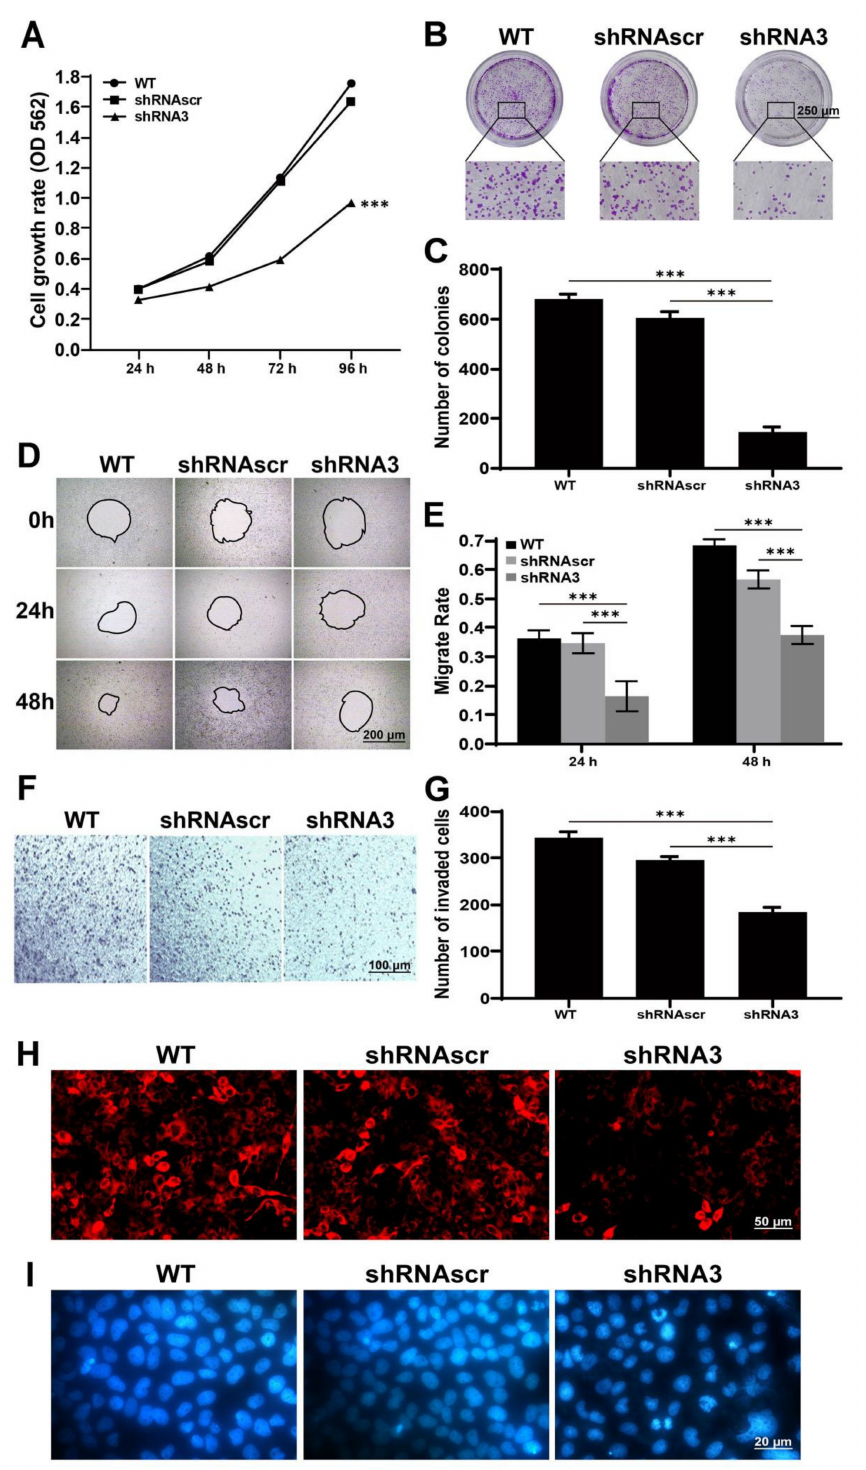
Figure 3. Knockdown of LEF1 inhibited cell proliferation and motility and induced apopto- sis in caco2 cells. ( A ): Cell viability determined by an MTT assay at 24, 48, 72, and 96 h af- ter transfection. ( B , C ): The growth of caco2 cells analyzed by a colony formation assay post- transfection (scale bar = 250 µ m). ( D , E ): Wound healing assay at 0, 24, and 48 h after scratching (scale bar = 200 µ m). ( F , G ): Transwell assay at 60 h after transfection (scale bar = 100 µ m). ( H ): Mito- chondrial detection by MitoScene 633 staining (scale bar = 50 µ m). ( I ): Nuclear detection by DAPI staining (scale bar = 20 µ m). *** p <